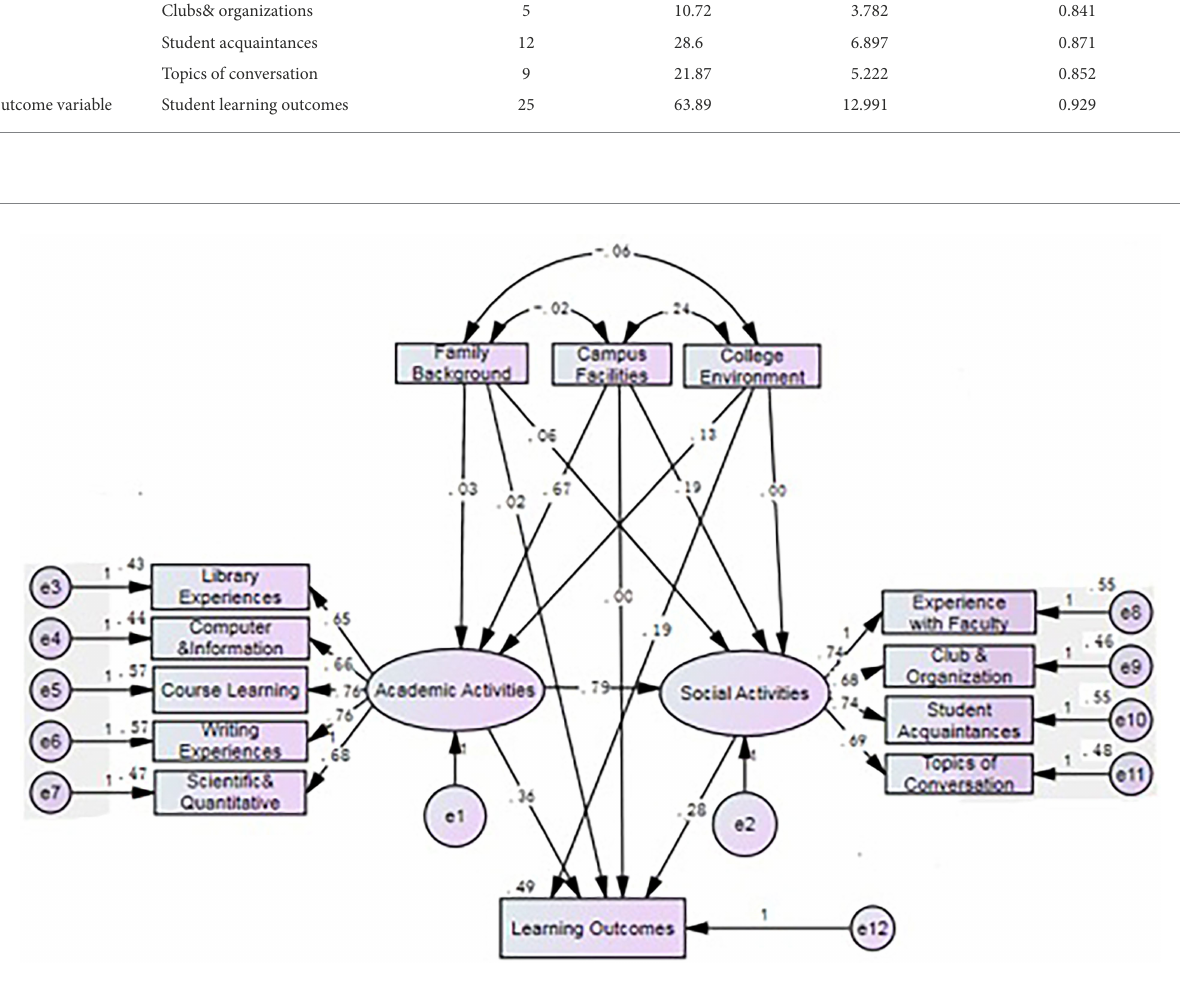
FIGURE 2 Standardized estimates from the structural equation